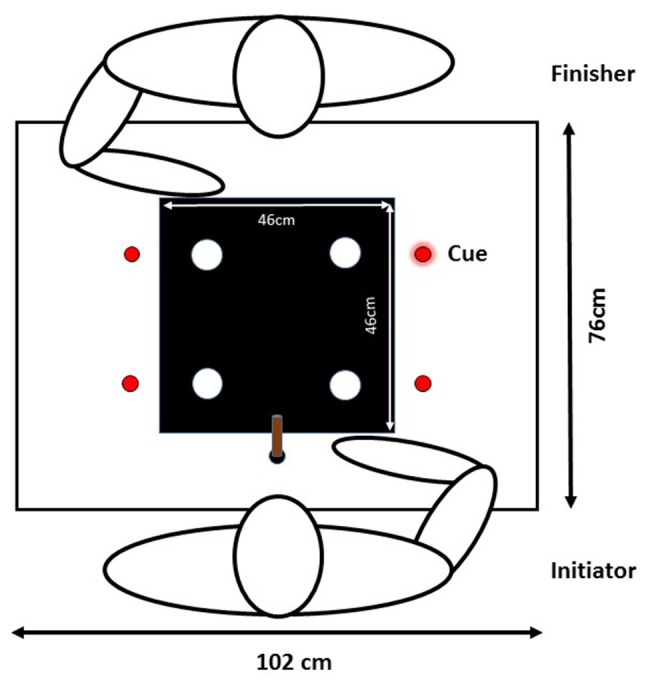
Diagram of the experimental set up for Experiment 1. Diagram depicts the presentation of a cue prior to the initiator's movement. The white circles are the four potential targets and the four red circles are spatial locations of the cues (i.e., light emitting diodes).